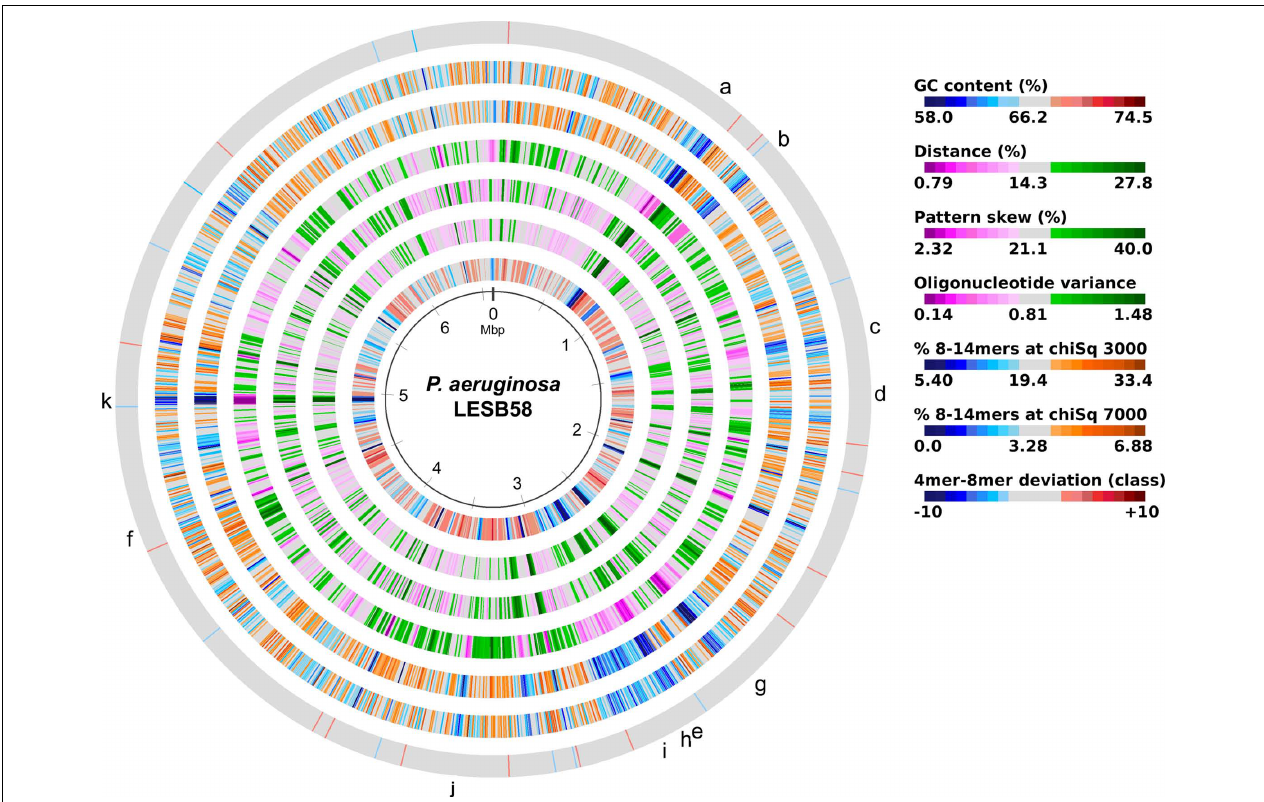
circle) is the numerical variance of oligomers, where a lower value indicates tetramer usage is more highly restricted (for example in repeat regions). Rings 5 ( χ 2 threshold 3000) and 6 ( χ 2 threshold 7000) display the number of bases occupied by overrepresented 8- to 14mers in a certain region, with overlaps only counted once, as a percentage.The outermost ring shows the difference (in classes) between a tetranucleotide parameter, oligonucleotide variance, and the 8- to 14mers in ring 5. Figures were created with JCircleGraph. Letters at the outermost ring indicate the regions of the six identified prophages (a–f) and five genomic islands (g–k;Winstanley et al.,